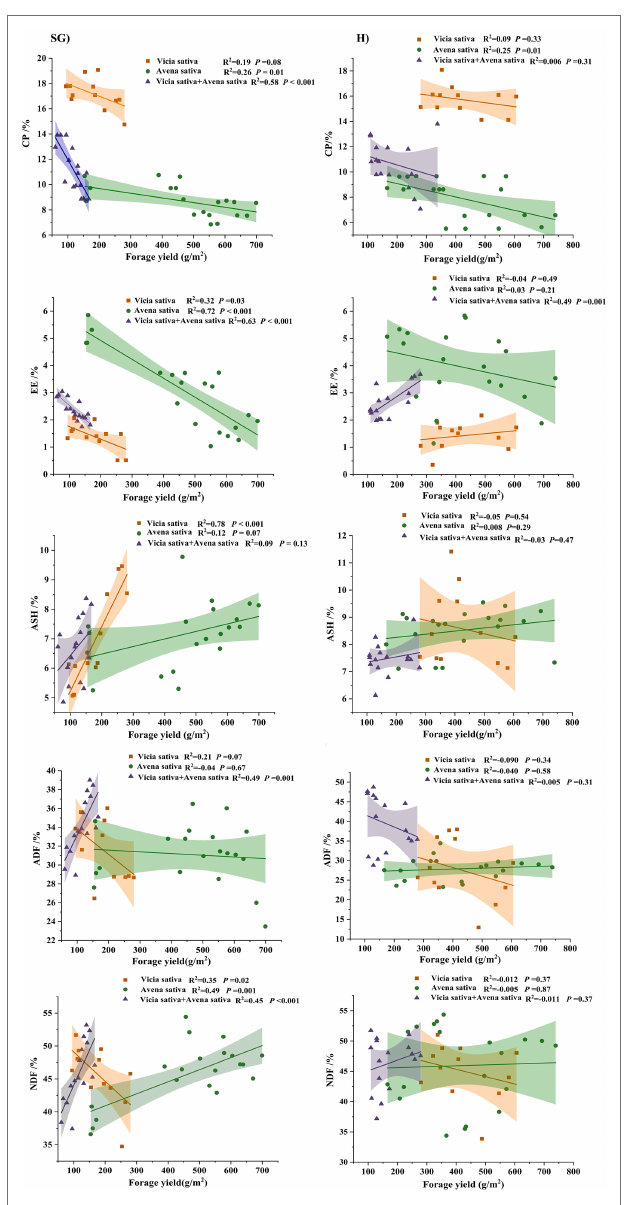
FIGURE 6 | Relationships between forage yield and crude protein (CP), crude fat (EE), Crude ash (ASH), neutral detergent fiber (NDF) and acid detergent fiber (ADF) under simulated grazing and harvesting hay treatments. Lines denote the linear